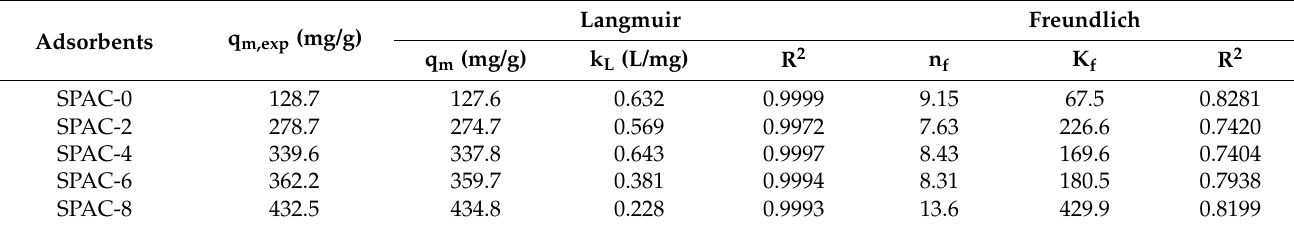
Table 2. Adsorption isotherm parameters and correlation coefficients (R 2 ) for the adsorption of MB onto SPACs. Adsorbents